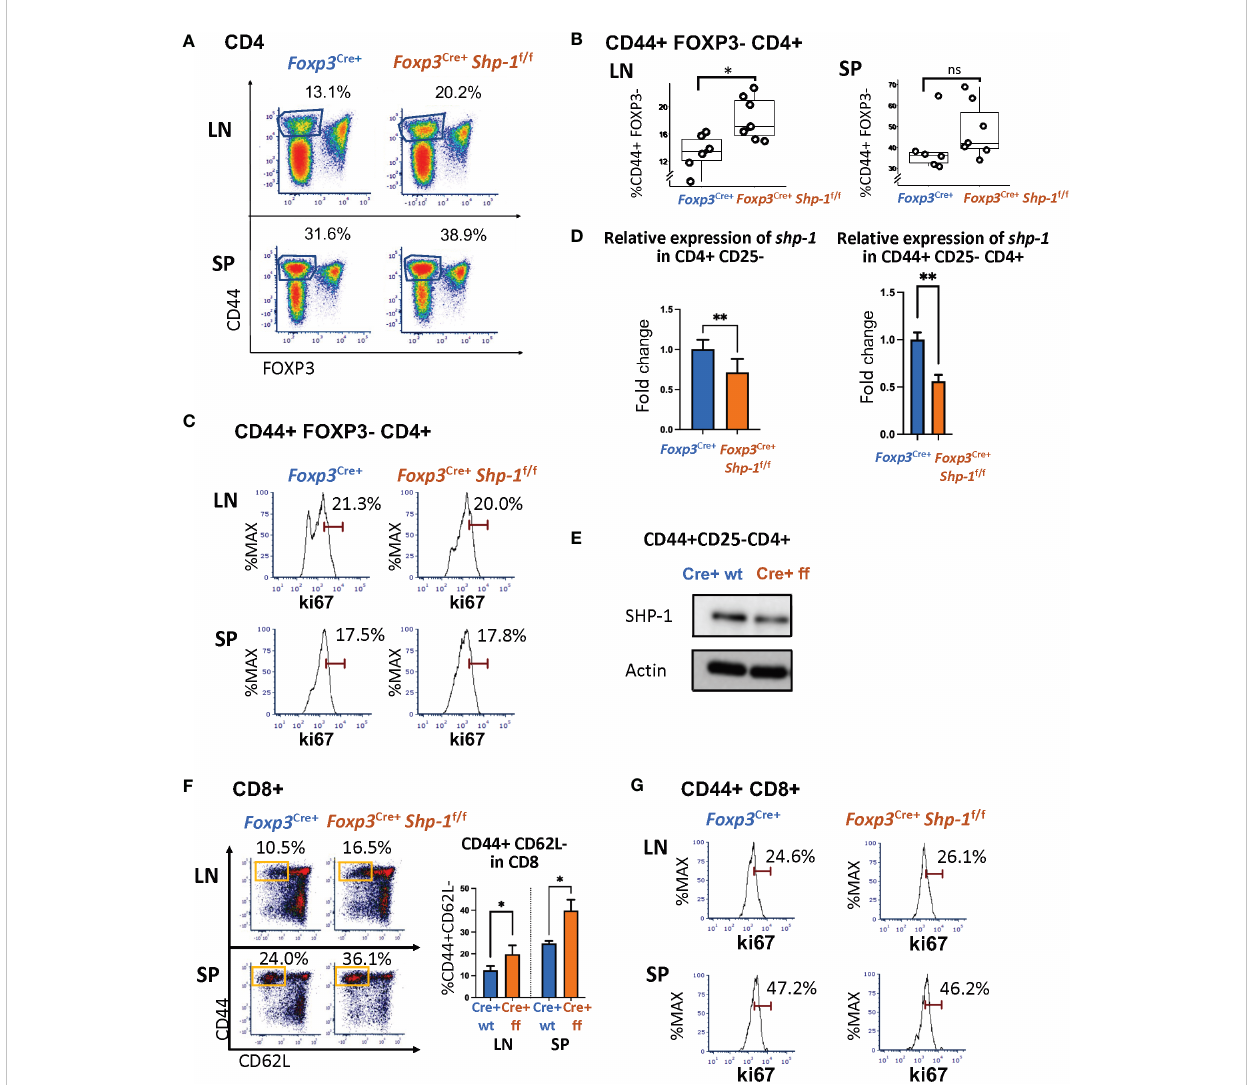
FIGURE 4 Treg speci fi c SHP-1 deletion affects non-Treg T cell population. (A , B) Percentages of CD44 hi Foxp3- within CD4+ T cell population of lymph nodes and spleen of Foxp3 Cre+ Shp-1 f/f or Foxp3 Cre+ mice. (A) Dot Plot is representative of 5 independent experiments. Percentages of CD44+ Foxp3- within CD4 populations are indicated. (B) Each dot represents one animal; lymph node p-value = 0.01, spleen p-value = 0.2537, two-sided t test. Gated: singlets ! live ! CD4. Student T test were performed for statistics. (C) Percentages of Ki-67+ within CD44 hi Foxp3- CD4+ T cells of lymph nodes and spleen of Foxp3 Cre+ Shp-1 f/f or Foxp3 Cre+ mice. Data are representative of 3 independent experiments. Gated: singlets ! live ! CD4 ! FOXP3- ! CD44. ( D left panel ) CD4+ CD25- cells or ( D right panel and E ) CD4+ CD44 hi CD25- cells were magnetically sorted from Foxp3 Cre+ Shp-1 f/f or Foxp3 Cre+ control mice and assessed for (D) mRNA expression via quantitative RT-PCR analysis of shp-1 mRNA (n =3 for each genotype, p-value for left panel = 0.0017, p-value for right panel = 0.0067) and for (E) SHP-1 protein expression via immunoblotting. Percentages of (F) CD44 hi CD62L lo (n= 3-4 for each genotype, p-value for LN=0.0379, p-value for SP=0.0282) and (G) Ki-67+ T cells within CD44+ CD8+ T cell population of lymph nodes and spleen of Foxp3 Cre+ Shp-1 f /f or Foxp3 Cre+ mice. Data are representative of 3 independent experiments. Gated: (C) singlets ! live ! CD4 ! FOXP3- ! CD44. (F) singlets ! live ! CD8. (G) singlets ! live ! CD8 ! CD44. Unpaired t test. *, p<0.05, **, p<0.01. ( D , E ) CD4+ CD44 hi CD25- cells were magnetically sorted from Foxp3 Cre+ Shp-1 f/f or Foxp3 Cre+ control mice and assessed for SHP-1 protein levels and mRNA expression via (D) Immunoblot and (E) Quantitative RT-PCR analysis of shp-1 mRNA. Percentages of (F) CD44 hi CD62L lo and (G) Ki-67+ T cells within CD8+ T cell population of lymph nodes and spleen of Foxp3 Cre+ Shp-1 f /f or Foxp3 Cre+ mice. Data are representative of 3 independent experiments. Gated: singlets ! live ! CD8. ns, not signi fi